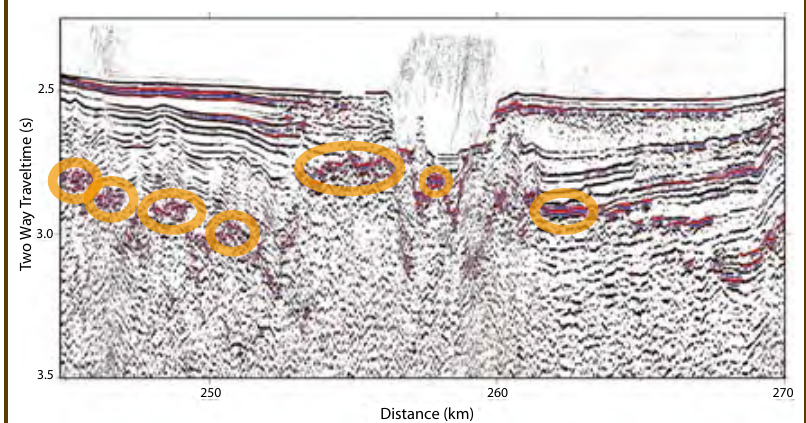
Figure 5. Multichannel seismic profile across the rift graben of the northern Guaymas rift segment of the Gulf of California (see Fig. 4 for location). Sills (circled; identified by reflectivity changes in the sediments they are intruding) drive hydrothermal circulation within the rift valley. Drilling in this vicinity will target thermal and geochemical fluxes as well as geobiological processes including methanogenesis. After Lizarralde et al. (2007).